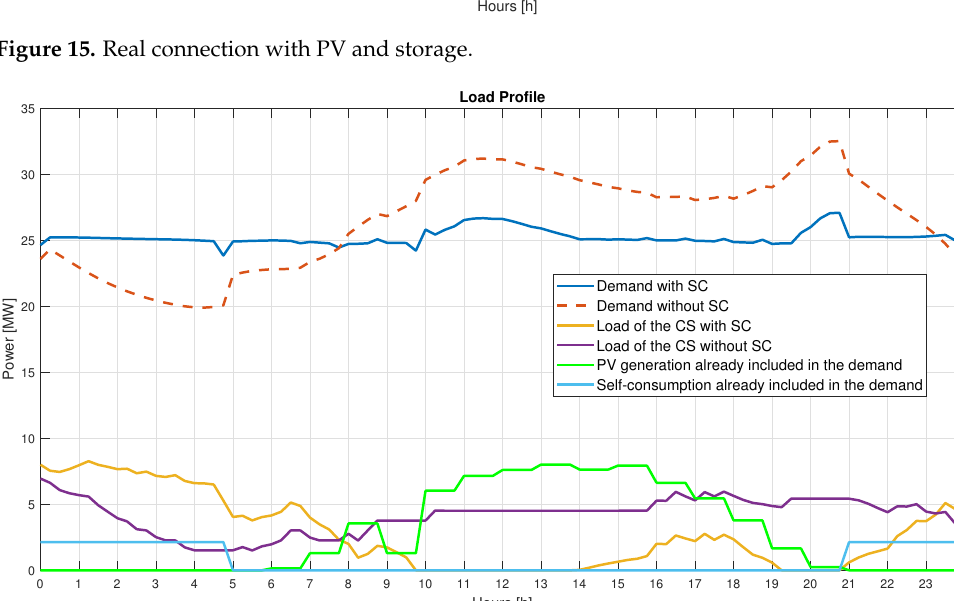
Figure 16. New real demand with PV and